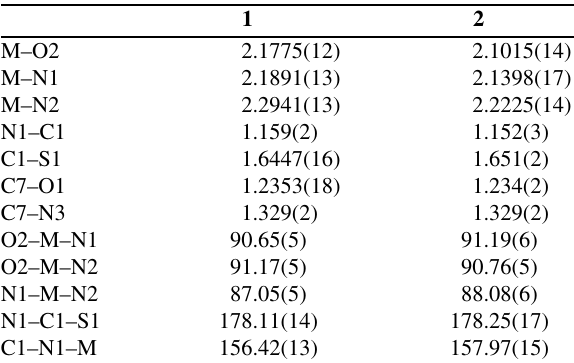
Table 2. Selected bond distances (Å) and angles (°) for complexes 1 and 2 .